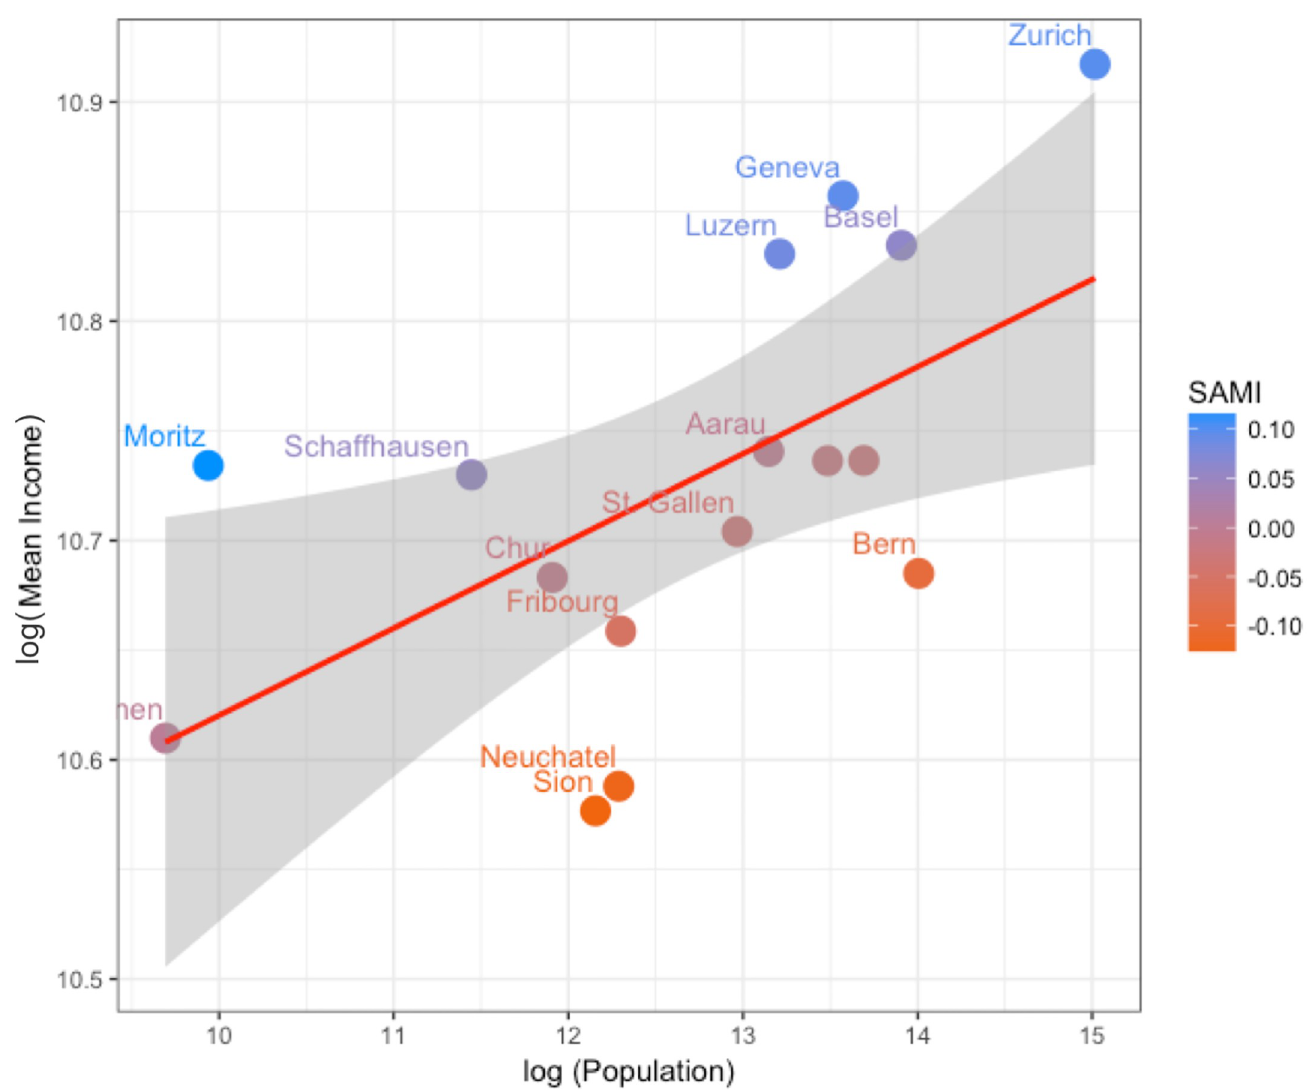
Fig 2. The relation between mean income and the population size of the metropolitan areas in Switzerland where β = 1.04 and Y 0 = 27447. The grey area indicates the 95% confidence interval. SAMI is the deviation from scaling law, which is used for ranking urban areas.